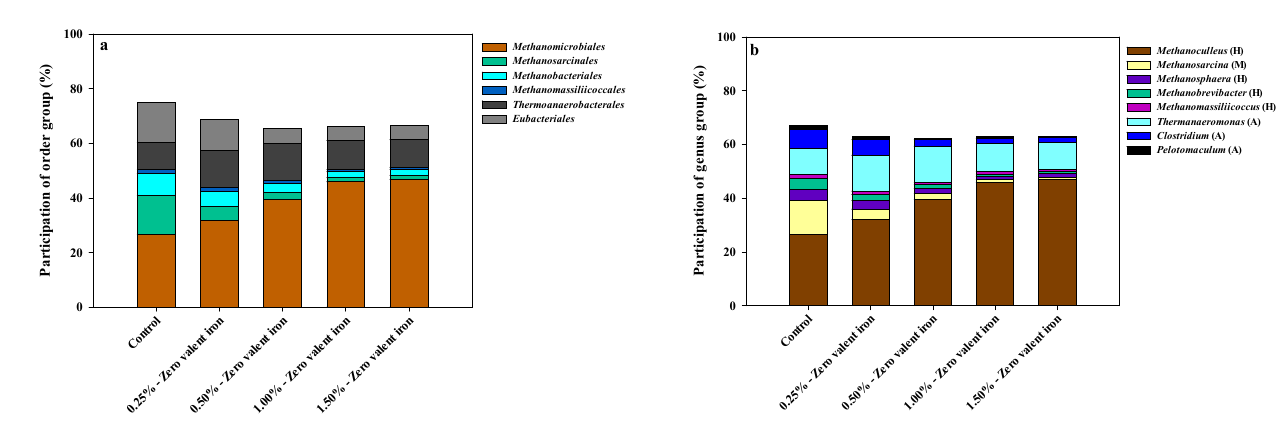
response to the concentration of the magnetite additive compared to the control group and ZVI.